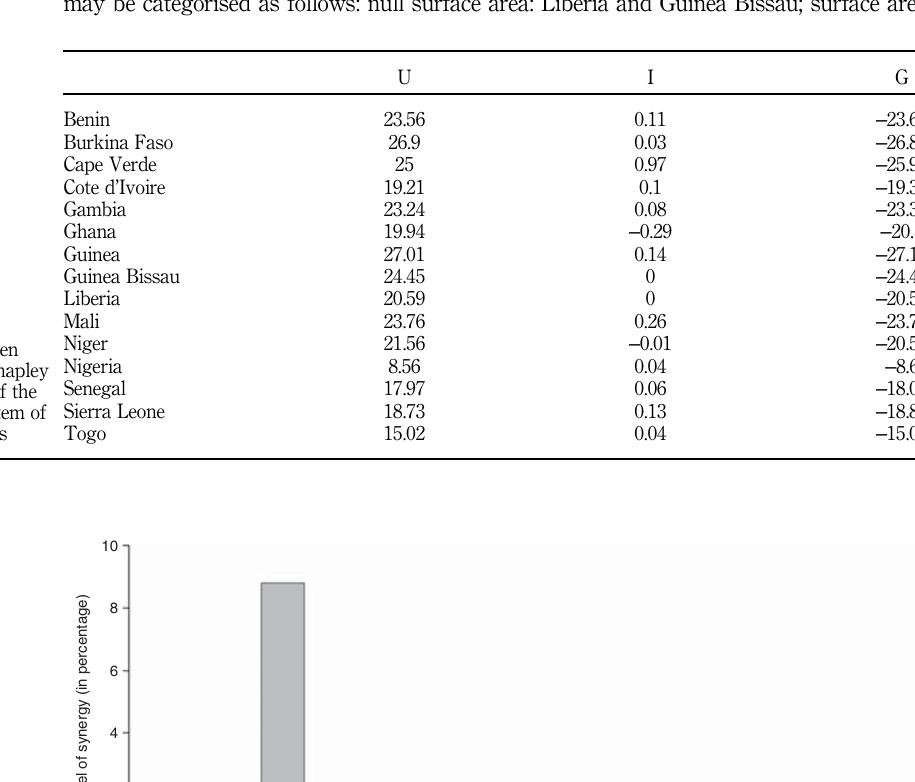
Figure 9. Level of synergy within West African national innovation